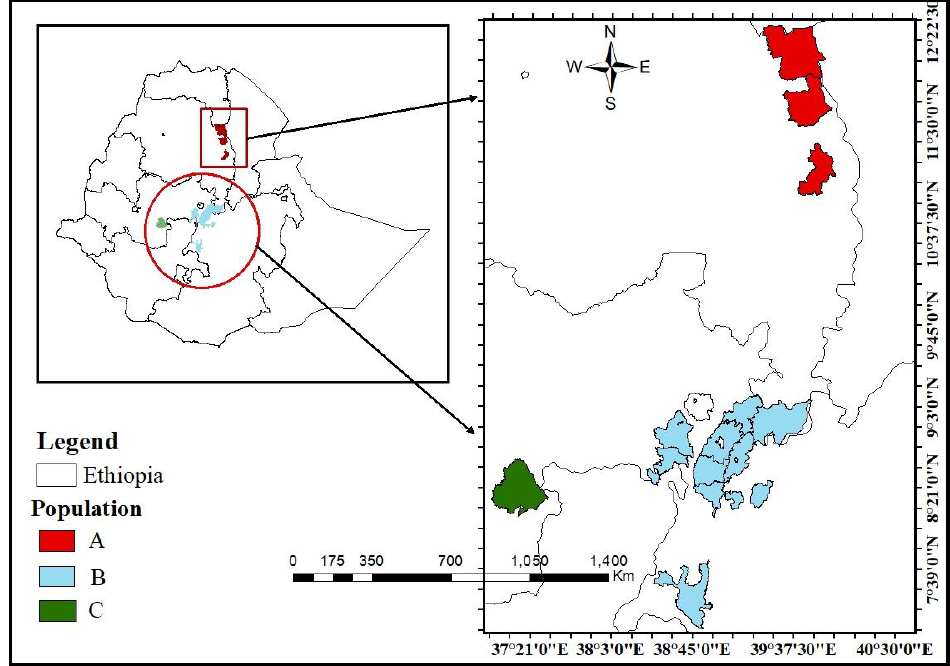
Figure 1. Isolate collection of D. rabiei from different chickpea growing agro-ecologies of Ethiopia. (A = northern population; B = central population; C = southern population).